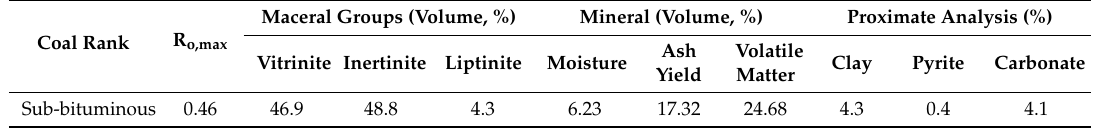
Table 2. The proximate analysis of the coal sample (%).